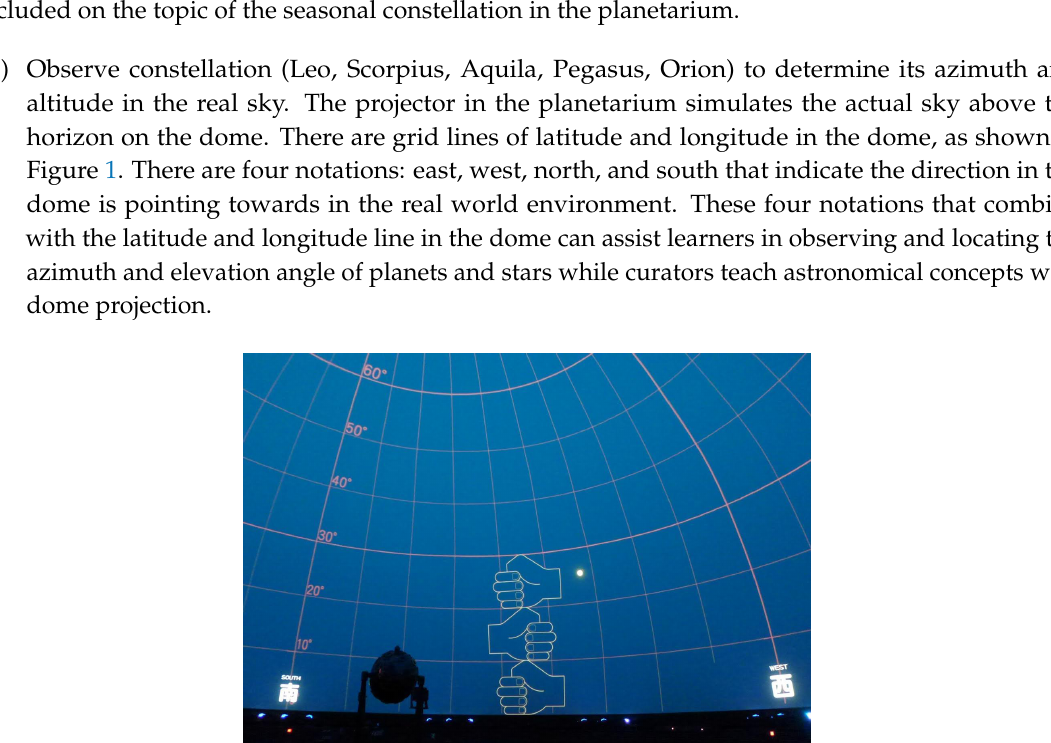
Figure 1. The grid line of latitude and longitude in the planetarium dome interface, and the interface of demonstrating the elevation angle between horizon and a start using a hand